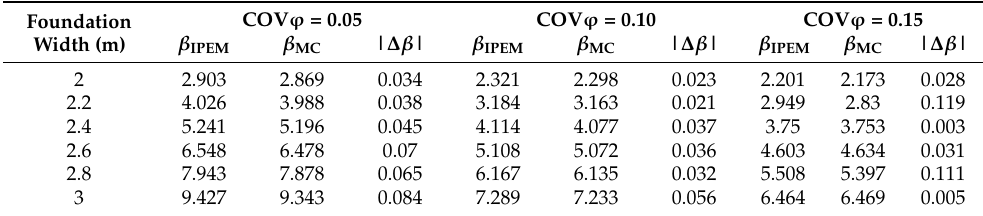
Table 3. The errors of the IPEM method for ULS.